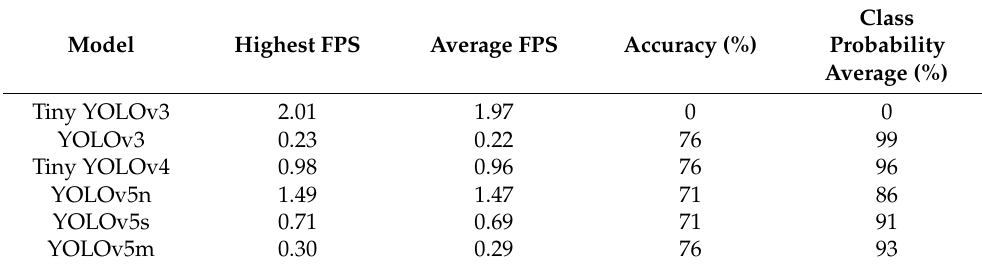
Table 3. Jetson Nano results comparing the YOLO models.